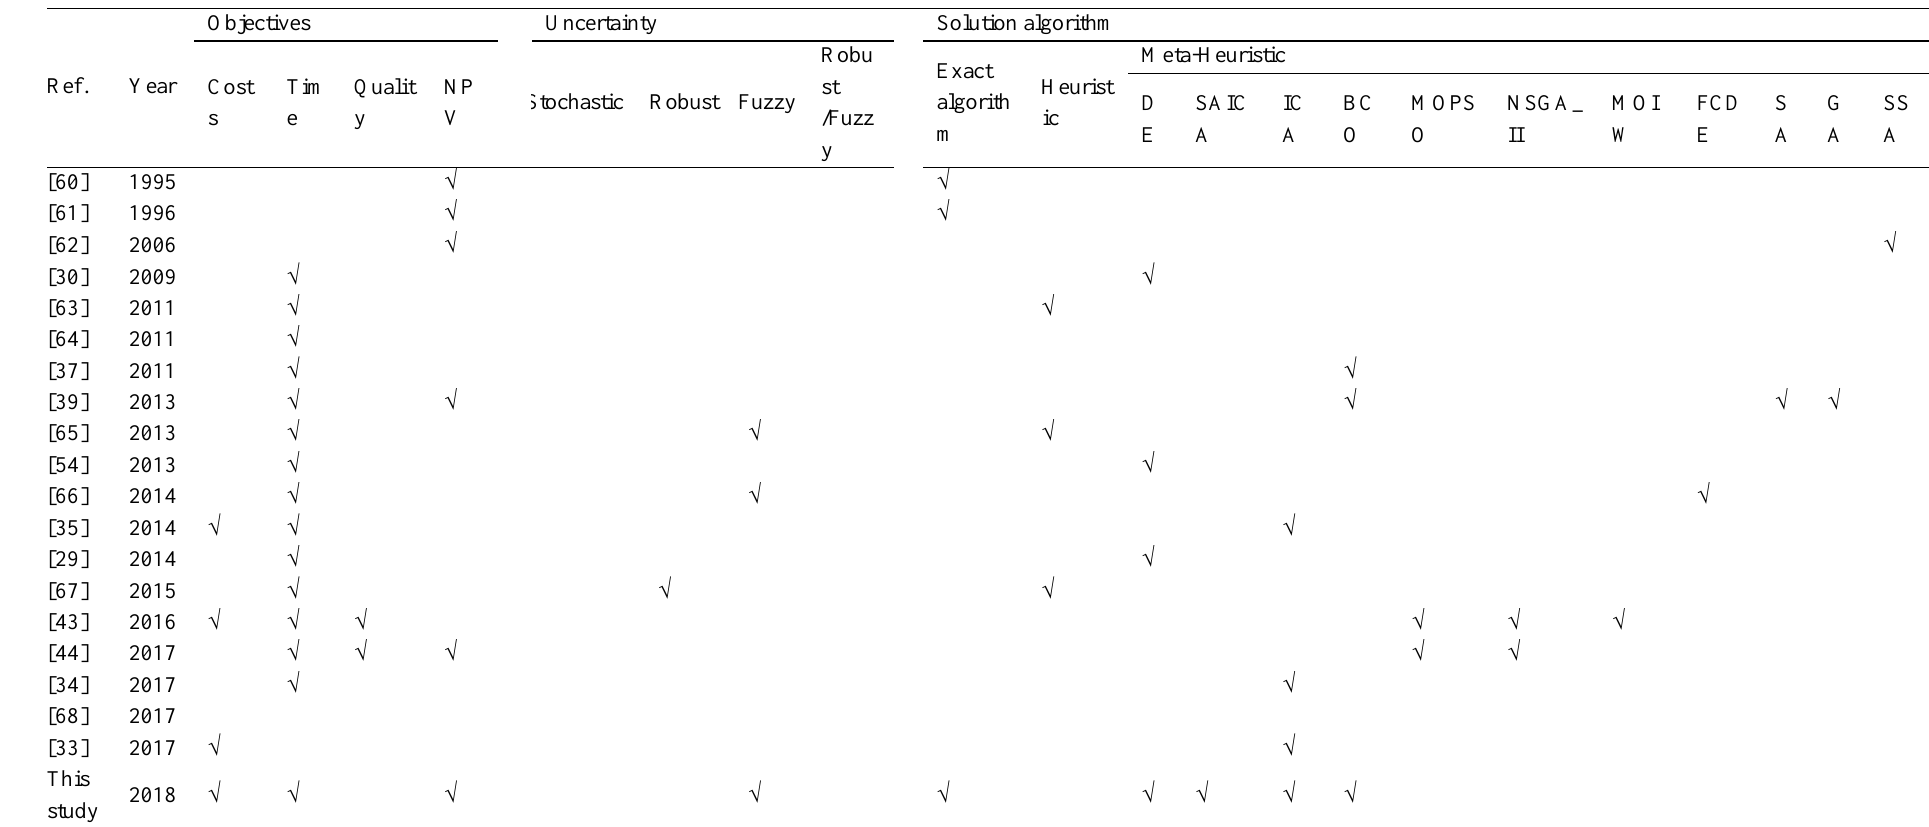
Table 1. Review of related